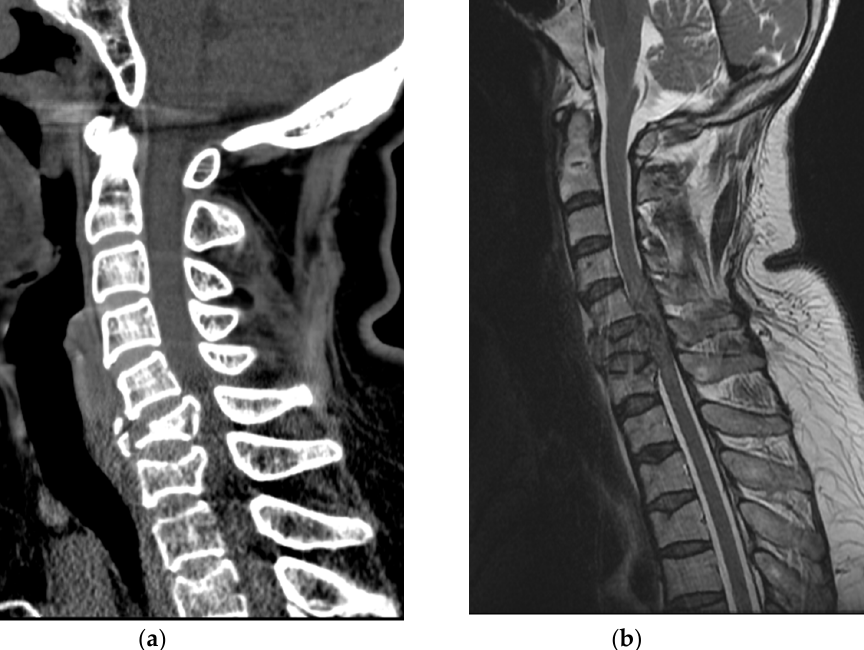
Figure 6. ( a ) Cervical spine CT showed C6, C7 vertebral body bursting fracture; ( b ) Cervical spine MRI revealed cord compression and heterogeneous signal change with hemorrhagic infiltration. During the examination, she was conscious with a Glasgow coma scale score 15 out of 15. She was 157 cm tall, weighed 67 kg, and had a BMI of 27.18. Her both legs were